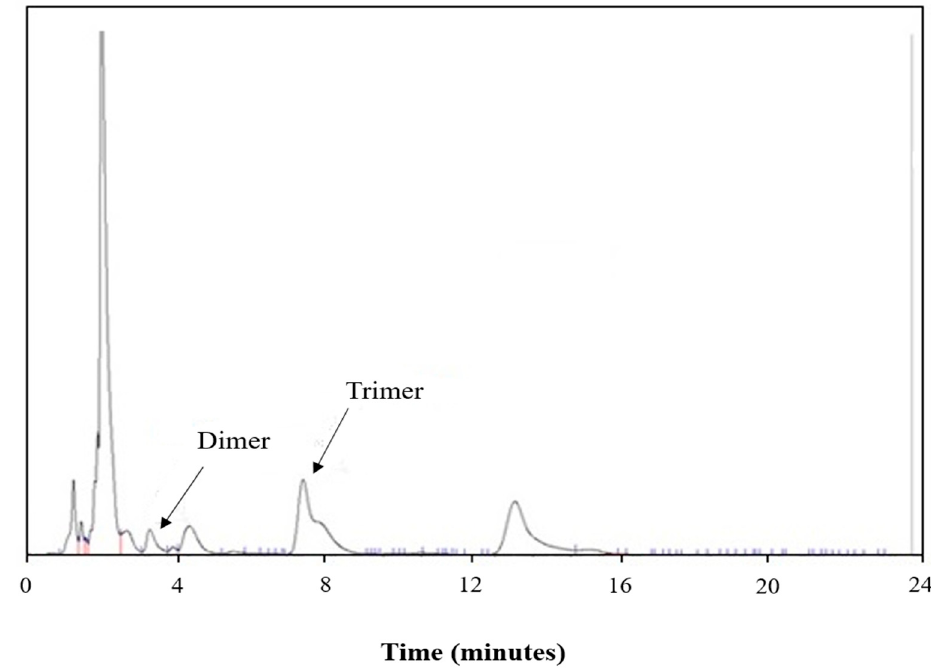
Figure 6. HPLC trace of PBT treated by the compressed CO 2 antisolvent technique at 8.3 MPa and 23.4 °C and with a PBT in HFIP concentration of 4.5 wt %.